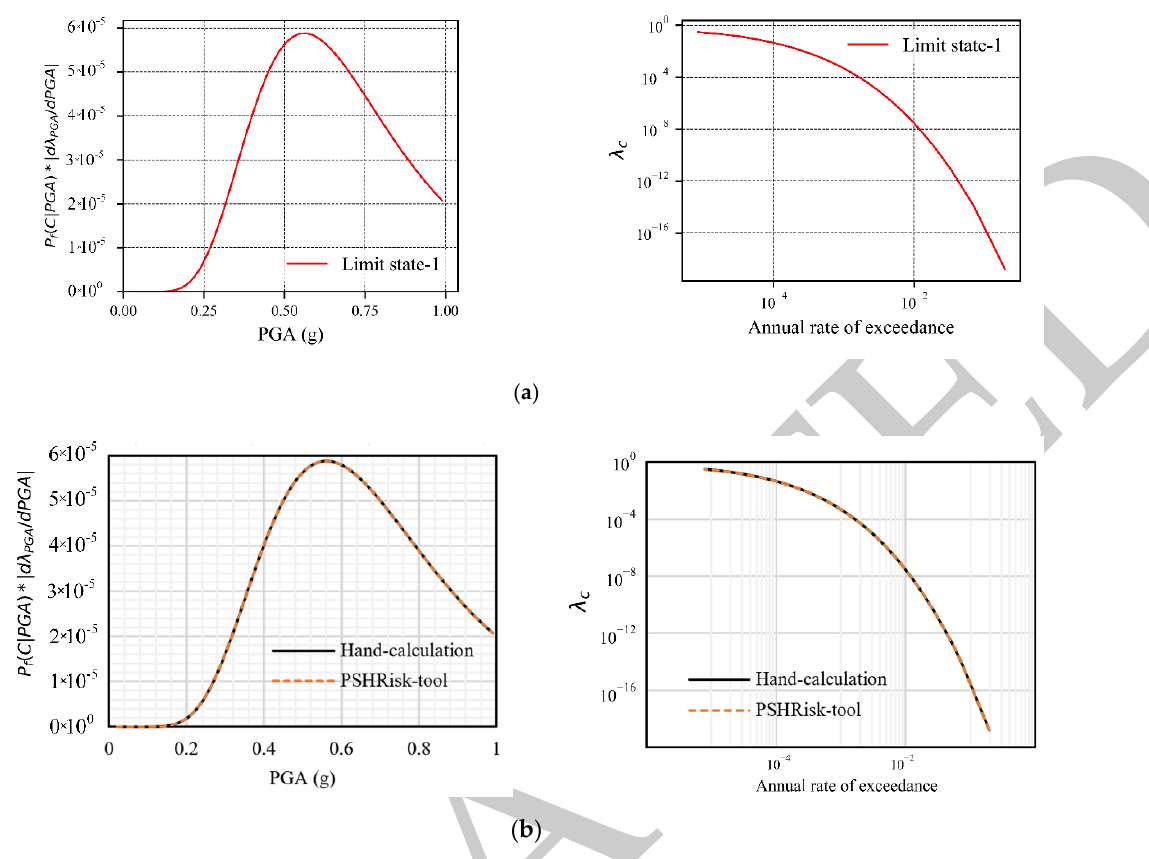
Figure 10. Verification of failure risk assessment curve, ( a ) PSHRisk-tool view, ( b ) Comparison.